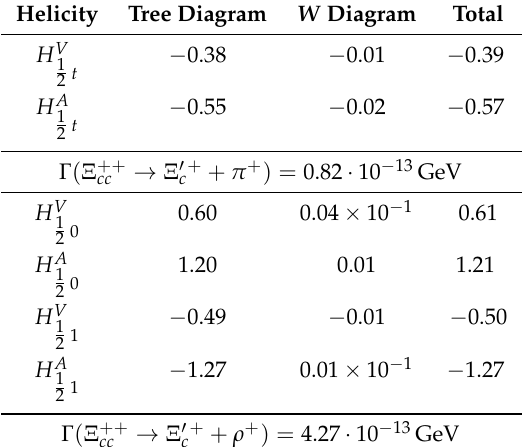
Table 6. Decays Ξ ++ cc → Ξ (cid:48) + c + π + ( ρ + )